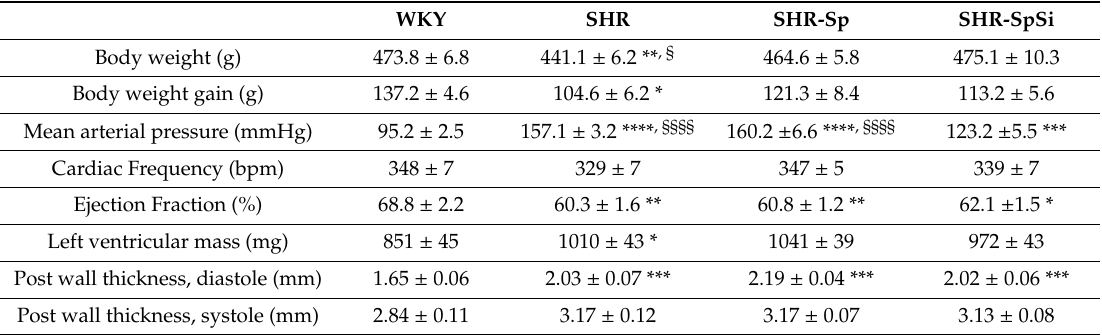
Figure 1. E ff ect of supplementation on arterial pressure. Blood systolic ( a ) and diastolic ( b ) arterial pressures were measured for all animals in each group ( n = 15). Values are in mmHg and data are presented as scatter plots with mean ± s.e.m. **** p < 0.0001, *** p < 0.001, ** p < 0.01 vs. WKY; §§§§ p < 0.0001, §§§ p < 0.001 vs. SHR-SpSi. Table 1. E ff ect of supplementation on body weight, arterial pressure and cardiac morphological and functional parameters.